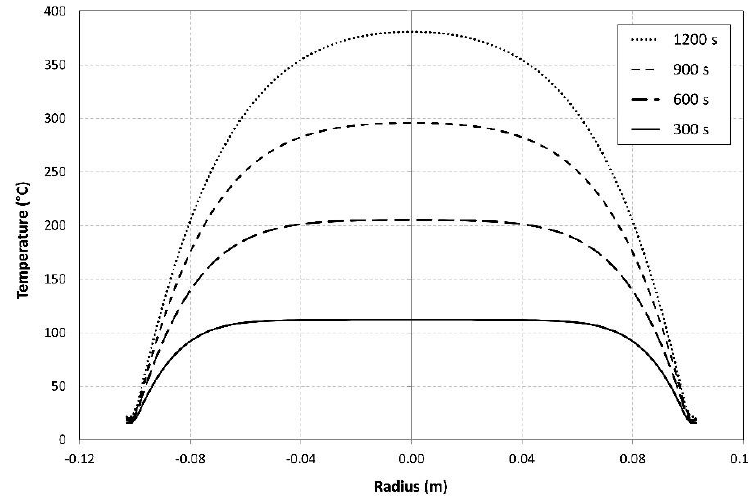
Figure 6. Changes in the temperature over time in the radial direction.